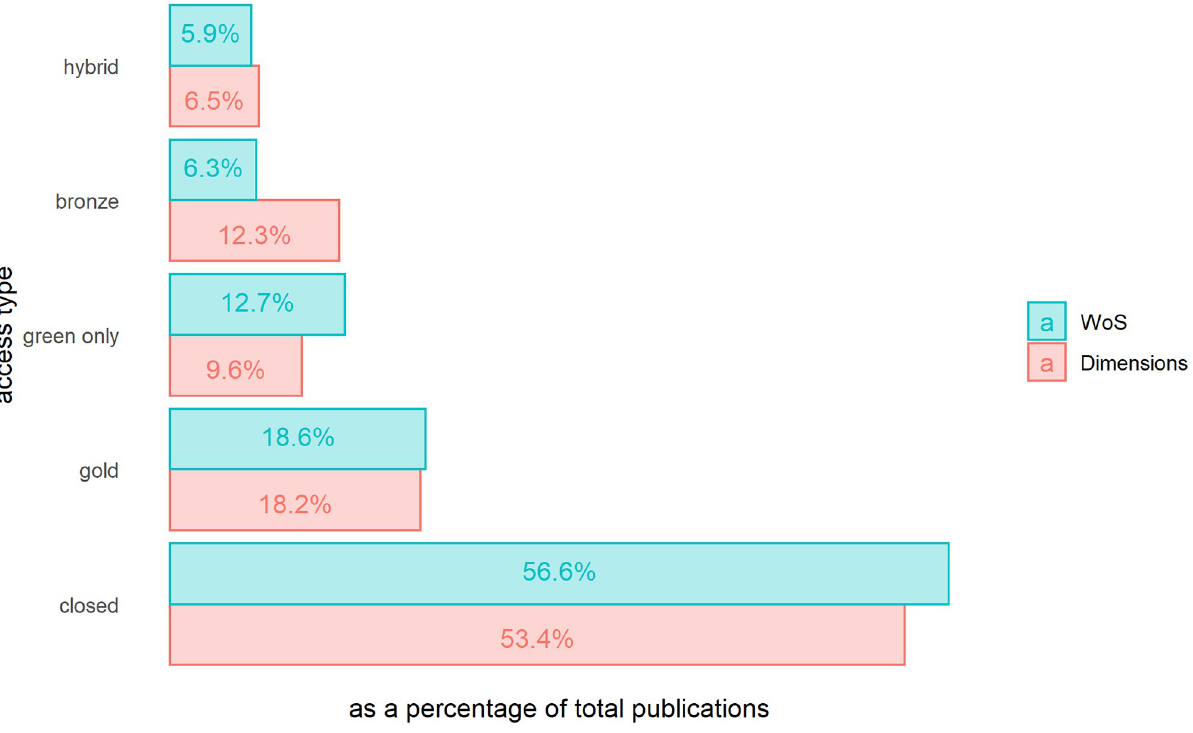
Fig 1. Percentage of open access publications, by access type and database,